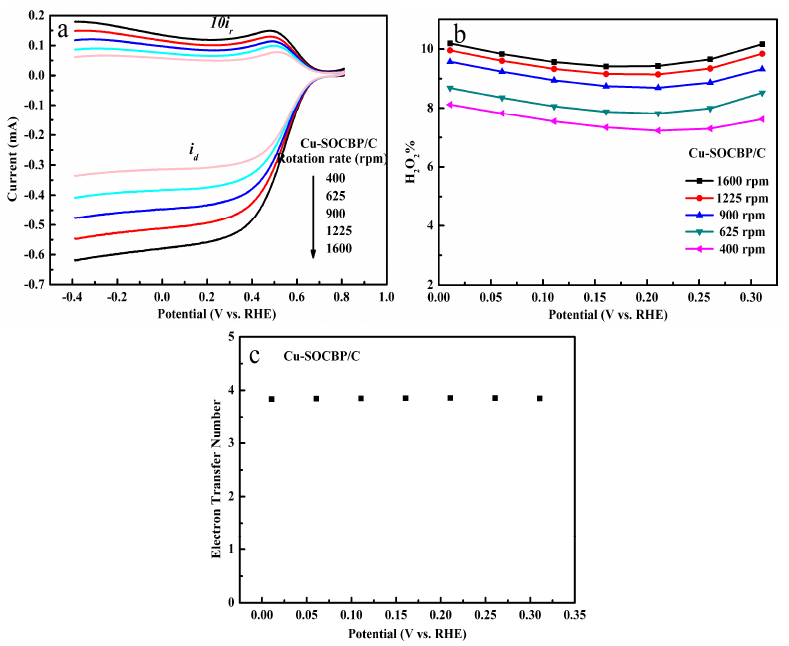
Figure 8. RRDE curves ( a ); peroxide yields ( b ); and n values ( c ) of Cu ‐ SOCBP/C.